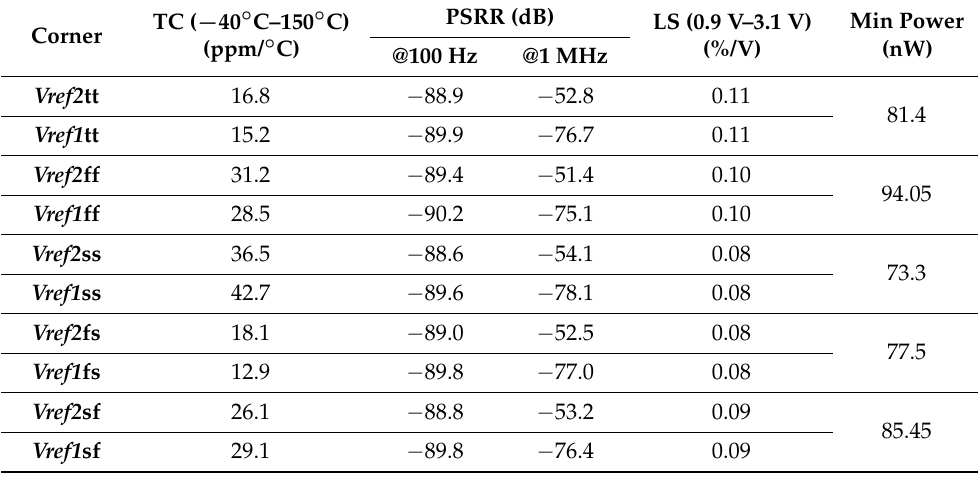
Table 2. The characteristics of the proposed voltage reference on different process corners.